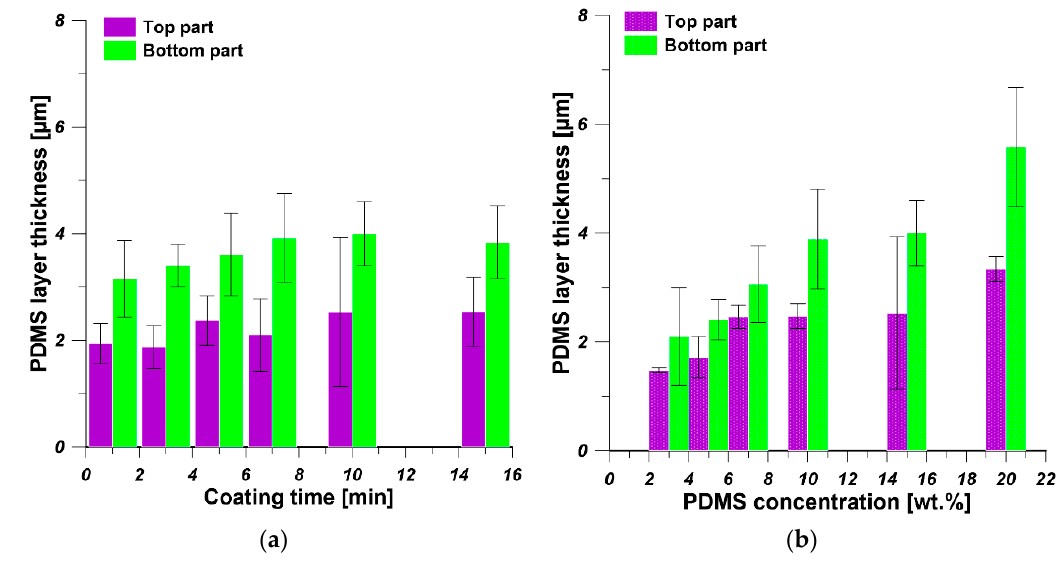
Polymers 2021 , 13 , 756 Figure 3. The thickness of PDMS selective layer: ( a ) the effect of coating time at constant concentration of PDMS solution equal to 15 wt%; ( b ) the effect of PDMS concentration at constant coating time equal to 10 min.